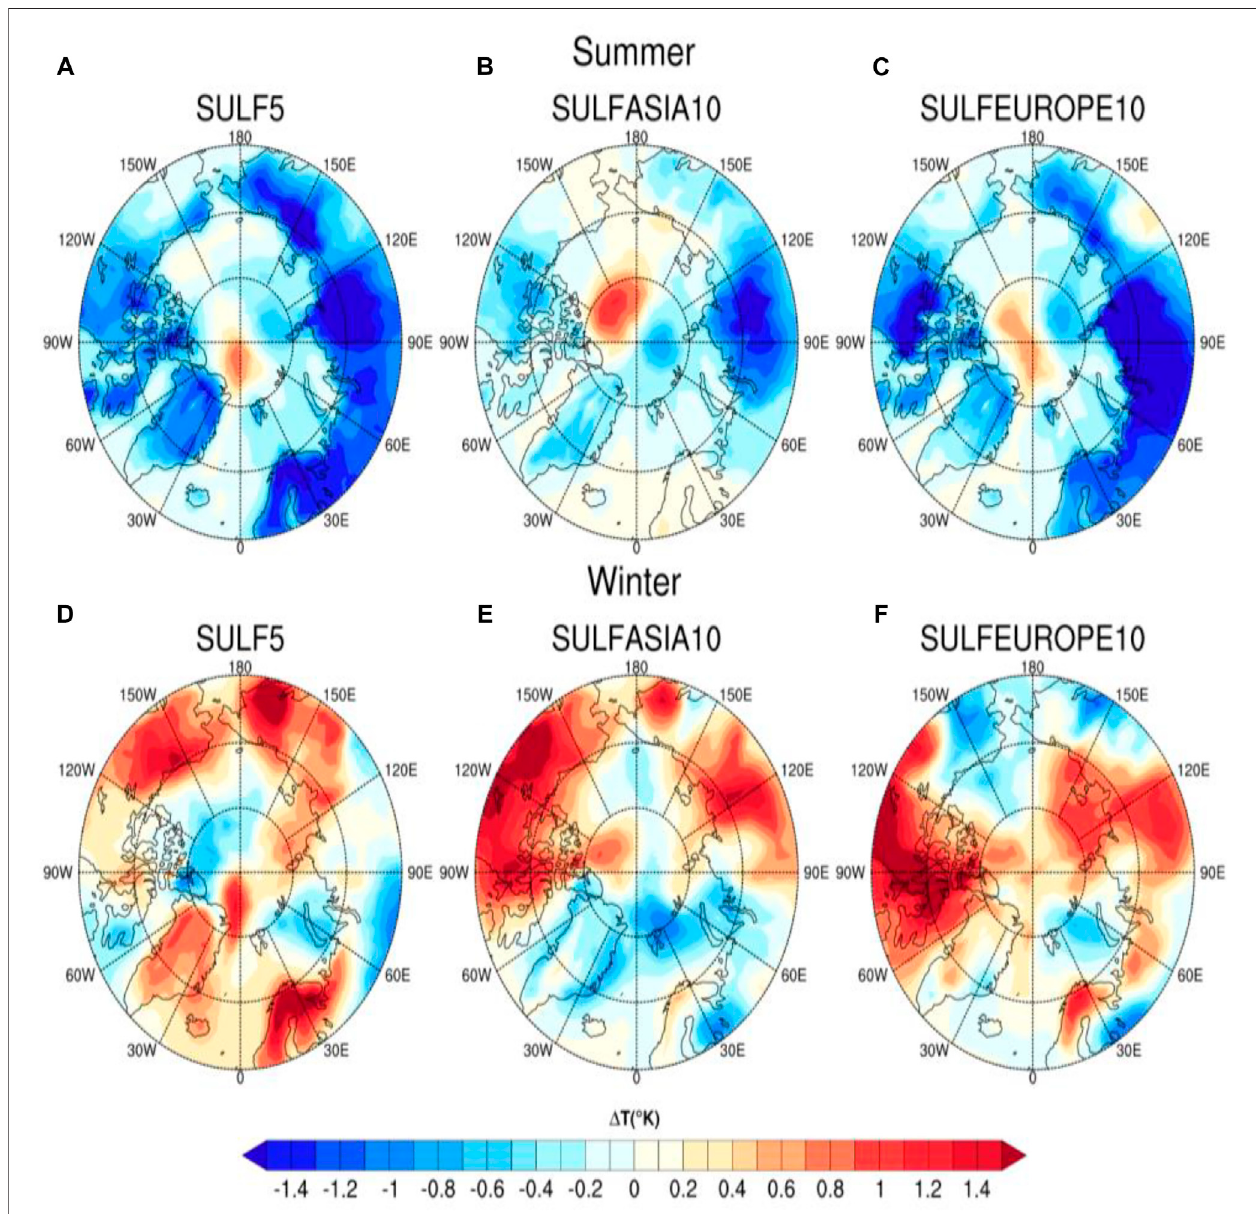
FIGURE 2 | Spatial changes (EXPTs minus CTRL) of near-surface temperature during summer (A – C) and winter (D – F) .